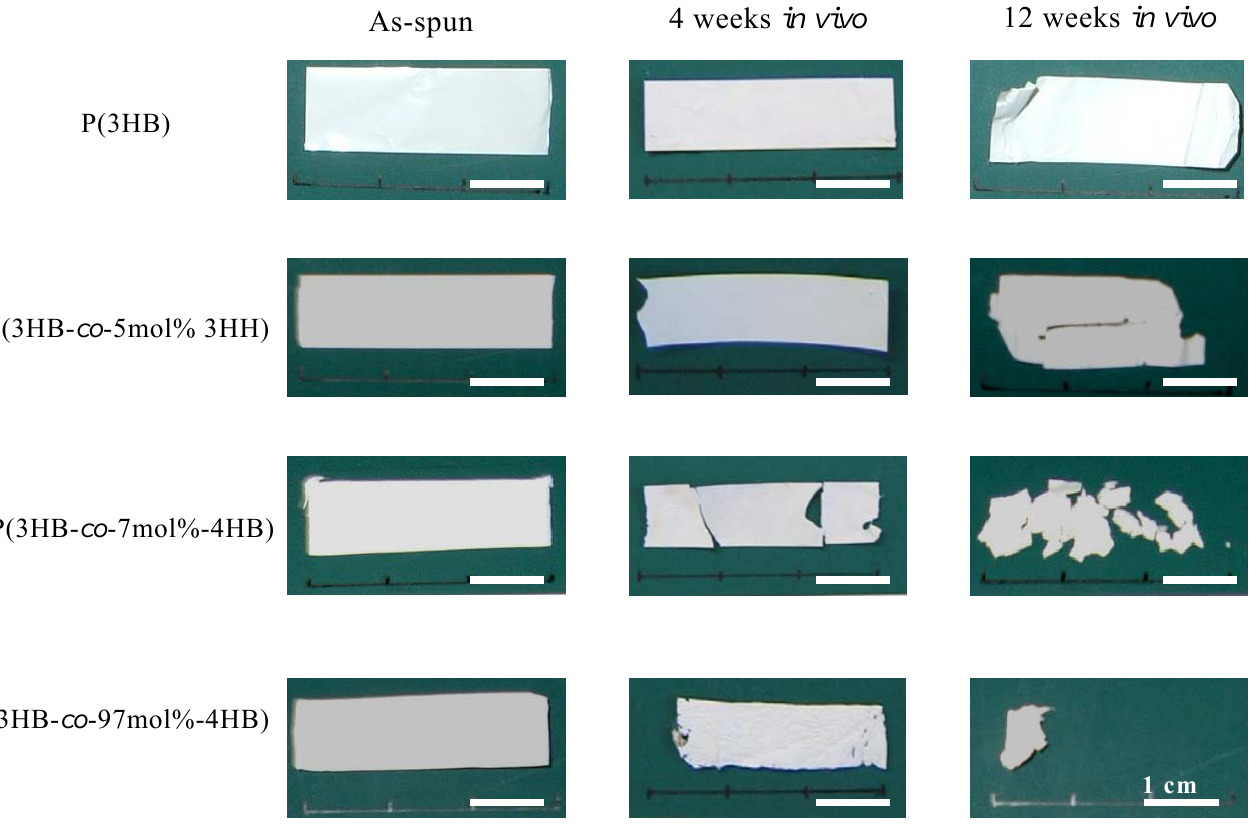
Figure 7. PHA nanofiber mats after subcutaneous implantation in rat for 4 to 12 weeks